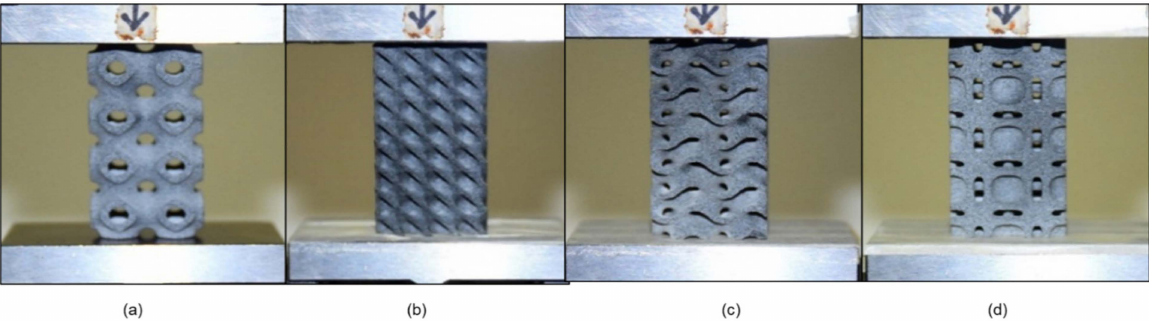
Figure 4. Configuration samples at 2 × 2 × 4 compressed to 0% compression. ( a ) Schwarz-P, ( b ) Diamond, ( c ) Gyroid and ( d ) Neovius.